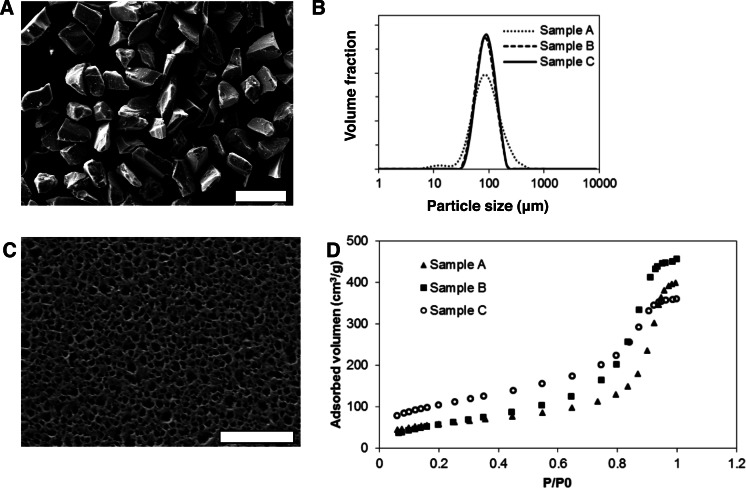
Morphological and physicochemical properties of mesoporous silicon microparticles (MS-MPs).(A) SEM image of MS-MPs (bar is 200 µm); (B) particle size distribution of the different MS-MP prototypes measured with a particle size analyzer; (C) example of a SEM image of the surface of MS-MPs (corresponding to prototype A, bar is 800 nm); (D) N2 adsorption isotherms, volume adsorbed vs. relative pressure (P/P0), for the different MS-MP prototypes.